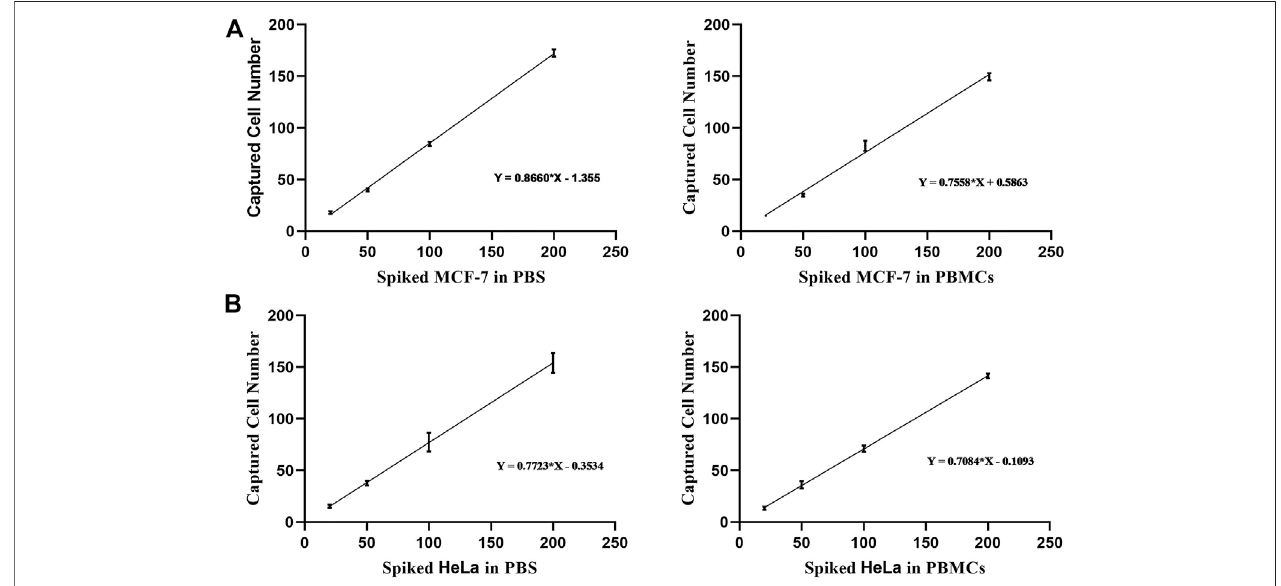
FIGURE6|(A) Analysisofthecaptureef fi ciencyforlownumbersofMCF-7cellsinPBSorPBMC-containingsolutions. (B) Analysisofthecaptureef fi ciencyforlow numbers of HeLa cells in PBS or PBMC-containing solutions.